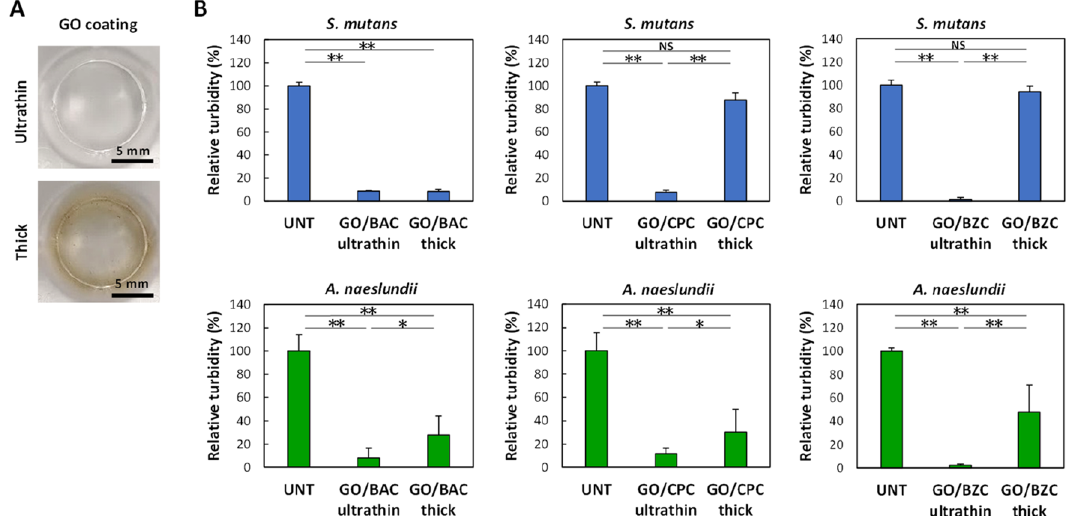
Figure 6. Comparison of GO ultrathin and thick films. ( A ) Digital photographs of culture well coated with GO ultrathin and thick films. ( B ) Relative turbidity (n = 6, mean + standard deviation) of S. mutans (top) and A. naeslundii (bottom) cultured on each well substrate. *P < 0.05, **P < 0.01. Statistical analysis: two-tailed one- way ANOVA with post-hoc Tukey HSD test. BAC benzalkonium chloride, BZC benzethonium chloride, CPC